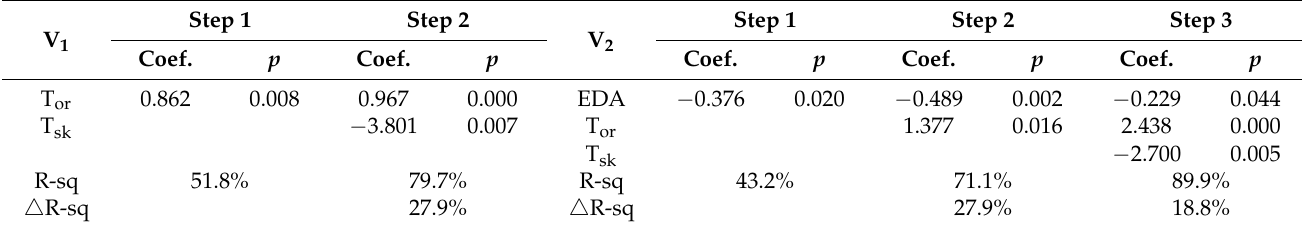
Table 4. Stepwise analysis of objective indicators and thermal comfort